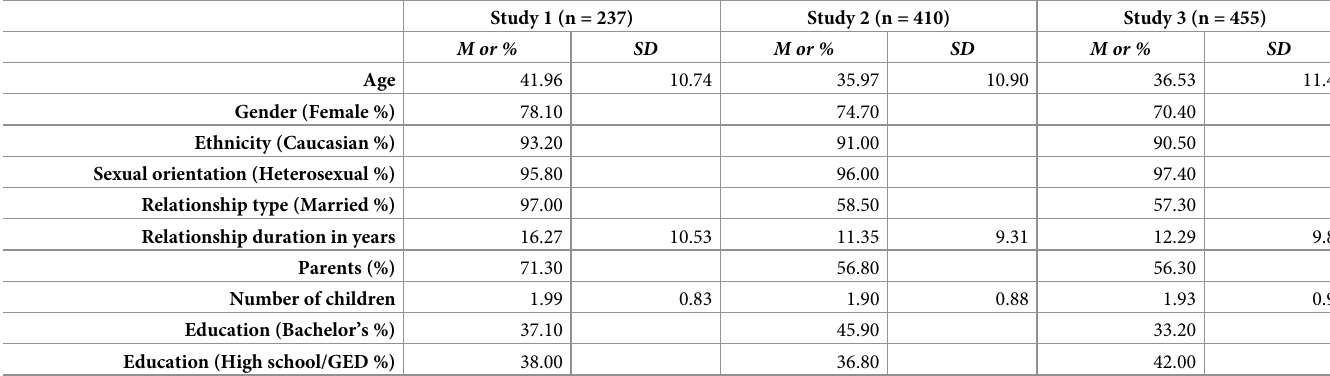
Table 1. Sample characteristics across